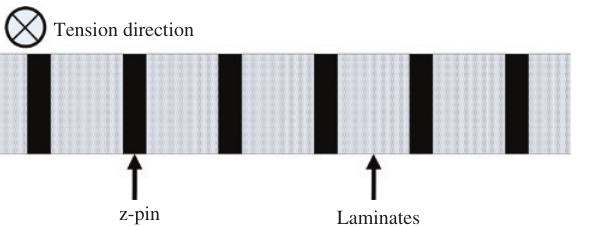
The length of the spring is 0.3 mm